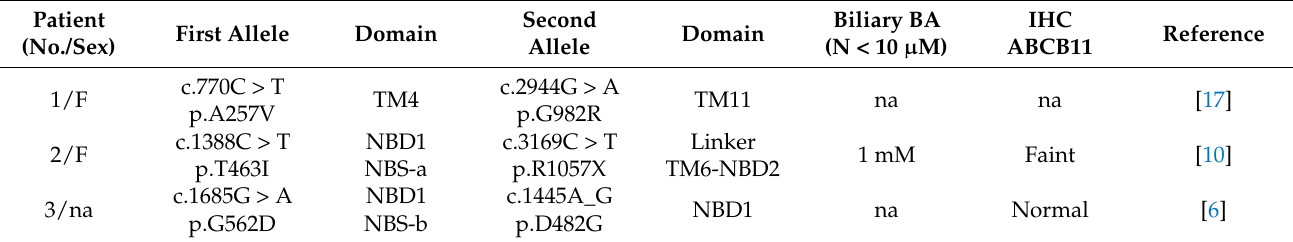
Table 1. Features of PFIC2 patients with ABCB11